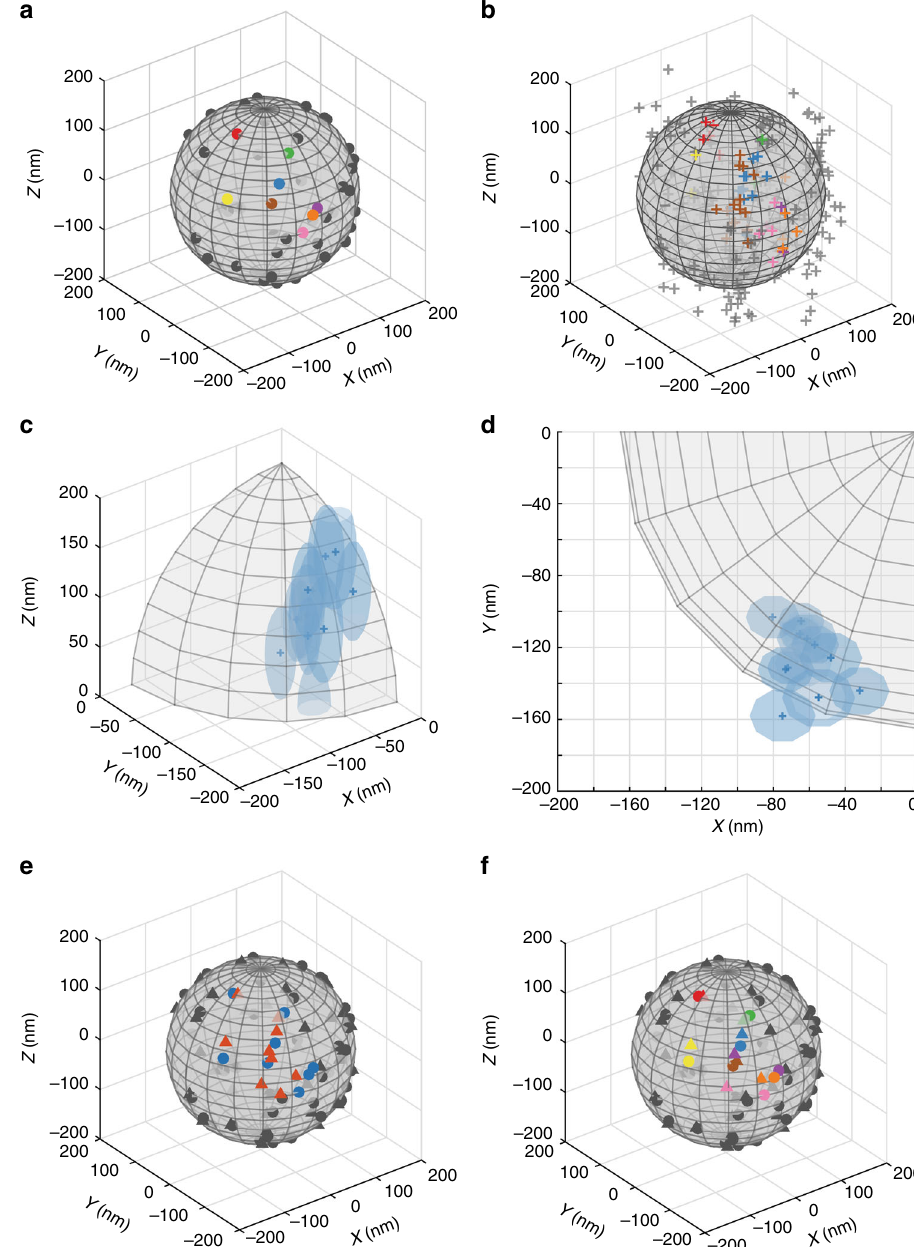
Fig. 4 Model-based validation of MLE for the fl uorophore distribution on a single nanoparticle. a Simulated fl uorophore locations (solid points) on a spherical nanoparticle (grey sphere) with a stochastically homogeneous spatial distribution. The number of fl uorophores is a realization of the introduced negative binomial distribution. The spatial locations are realizations of a uniform distribution over the surface of the sphere. b Simulated clusters of localizations (crosses) based on the generated fl uorophore locations in Fig. 4a. The simulations of the dSTORM imaging process are generated realizations of the probabilistic model described in detail in the Supplementary Methods. c Measurement uncertainties for each localization, dependent on brightness and z-position. The uncertainty is graphically depicted as an ellipsoid of one standard deviation in three dimensions (transparent surface). Only localizations associated with the fl uorophore colour-coded in blue are depicted. d Measurement uncertainties viewed along the z -axis. e Final MLE estimates of the fl uorophore locations (solid triangles), resulting from the EM-algorithm based on the simulated localizations and associated uncertainties. The actual locations of simulated fl uorophores are indicated for reference (solid points). f Matching of estimated and actual simulated fl uorophore locations, using the Hungarian algorithm given the real number of dyes. Matched pairs are indicated by identical colours. The average distance between pairs is a measure of the estimation error in the MLE We then approximate the locations of the source fl uorophores localization-based image (Fig. 4b). Using this simulated image as input, fi rst the most likely number of dyes based on the com- pound negative binomial distribution is calculated using the number of localizations (vide supra).